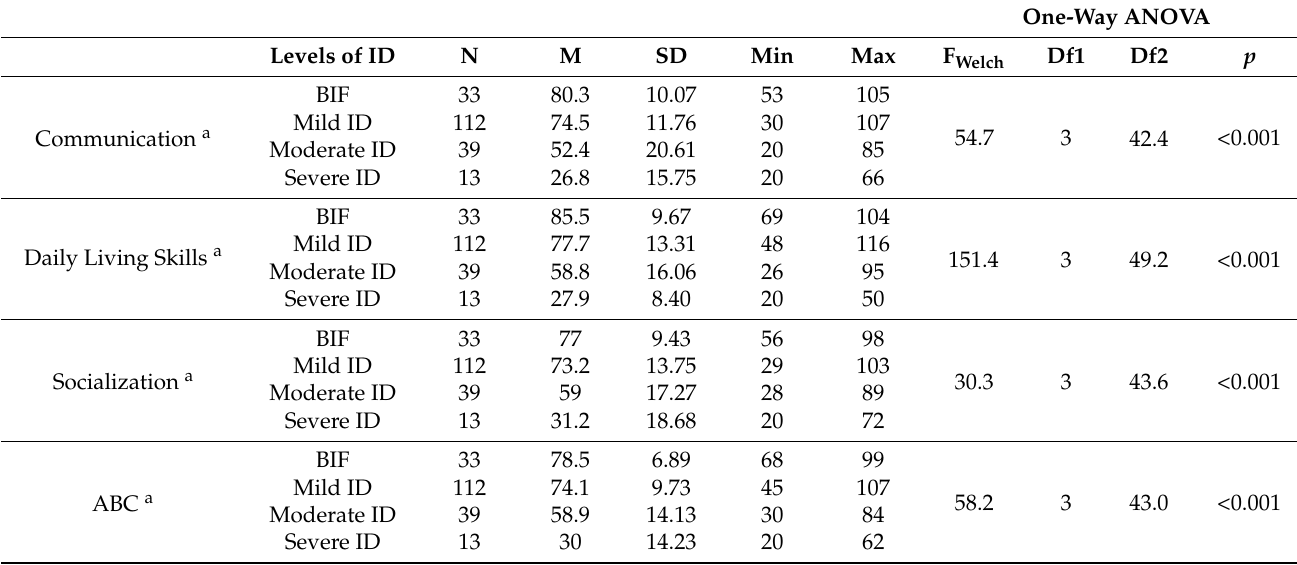
Table 2. Comparison of Standard scores for AB domain in each level of